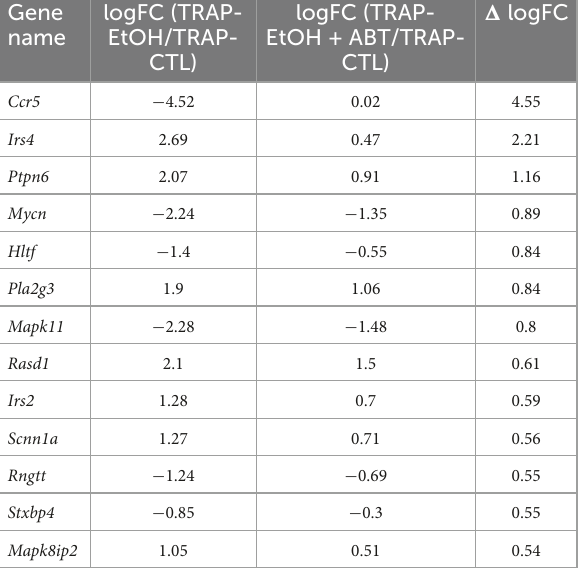
TABLE 3 Genes with the highest magnitude of reversal with coadministration of EtOH and ABT-888, corresponding to a difference in logFC > 0.50.